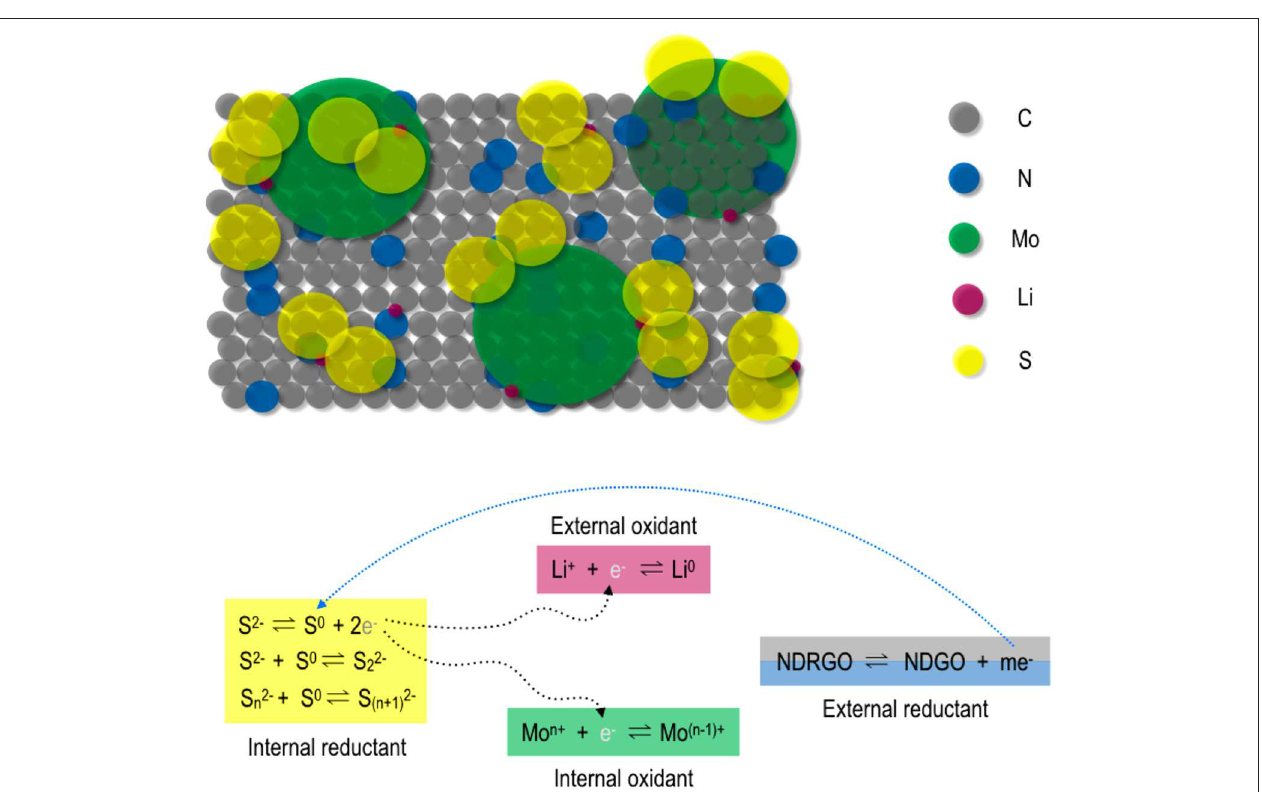
FIGURE 10 | Induced electron transfer in N-doped reduced graphene oxide-Mo-Li-S electrode; where m stands for number of electrons.